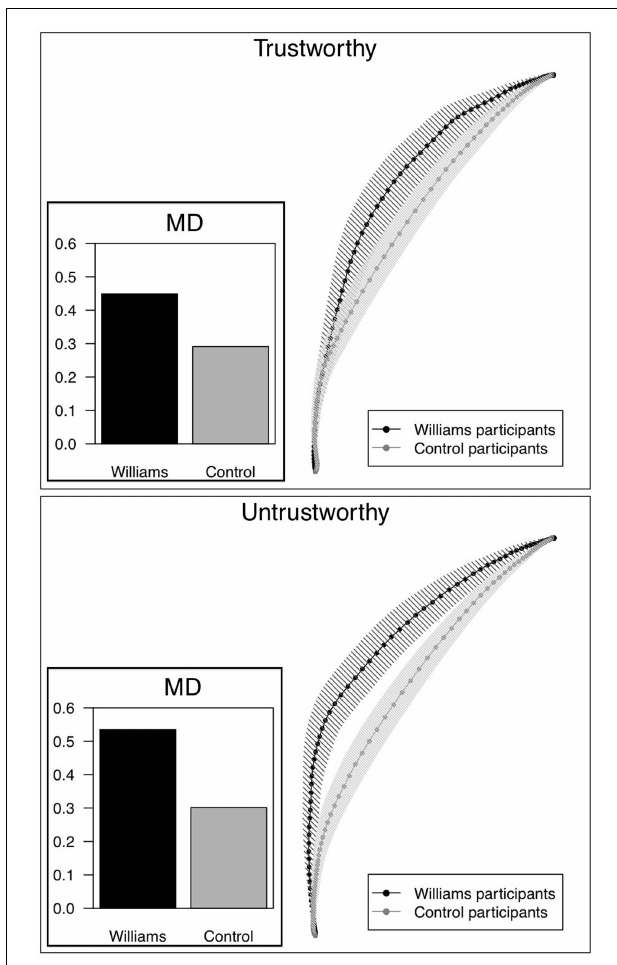
FIGURE 3 | Mean trajectories by face type (trustworthy, untrustworthy) forWilliams and control participants, aggregated across extremity of faces and across trials. Shaded region is plus/minus one standard error for each average mouse position. Bar graph shows the adjusted mean maximum deviation for each group of